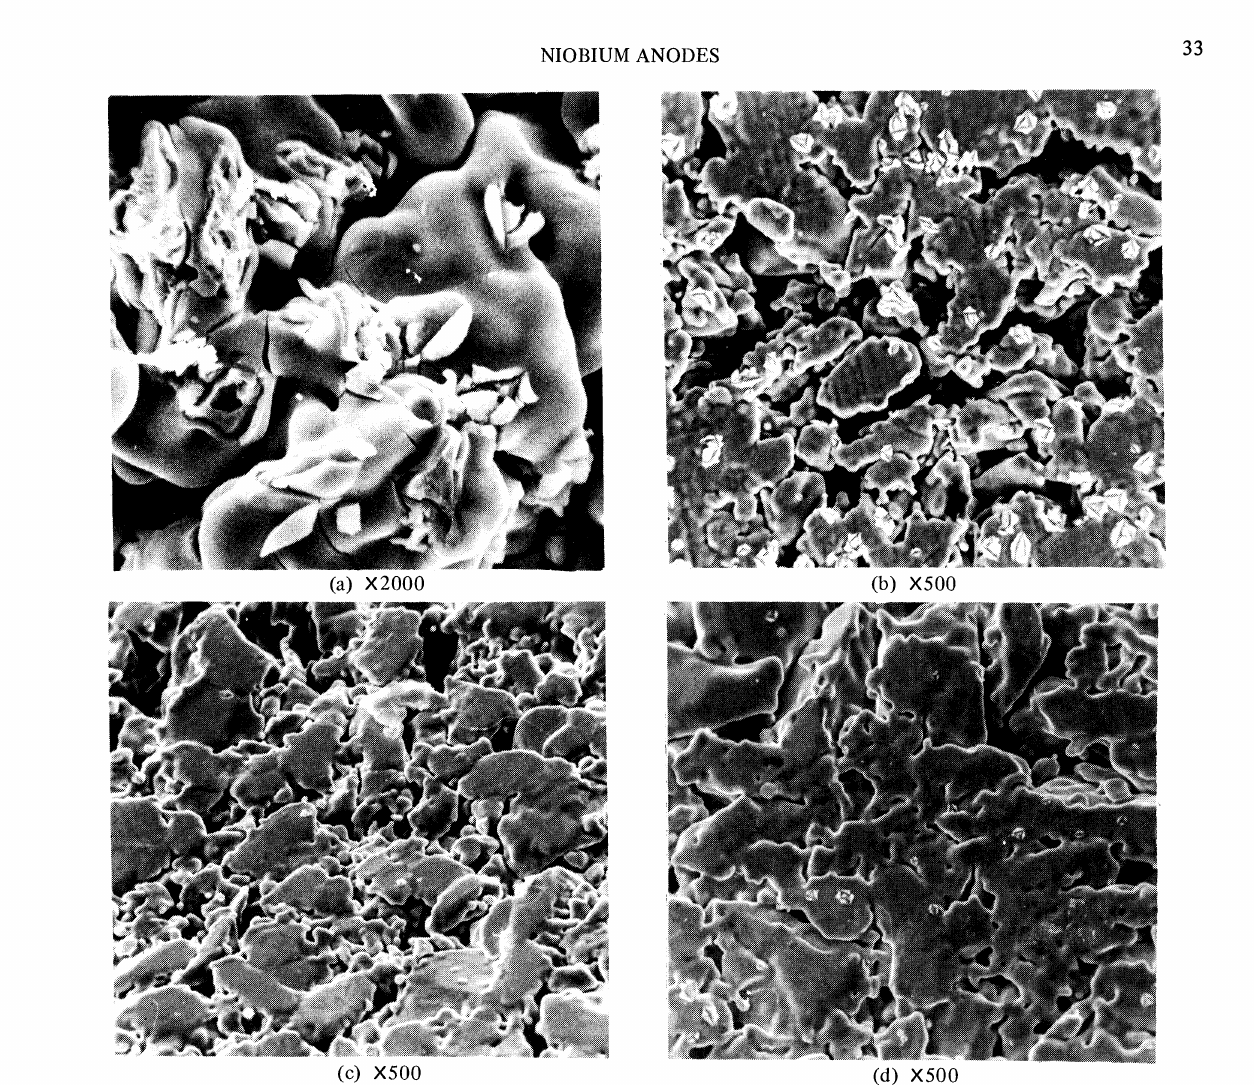
Niobium anodes formed in 1% H PO at 160V or 200V: (a) powder A sintered 1600C, formed 160V, section, (b)as (a), surface, (c) powder B sintered